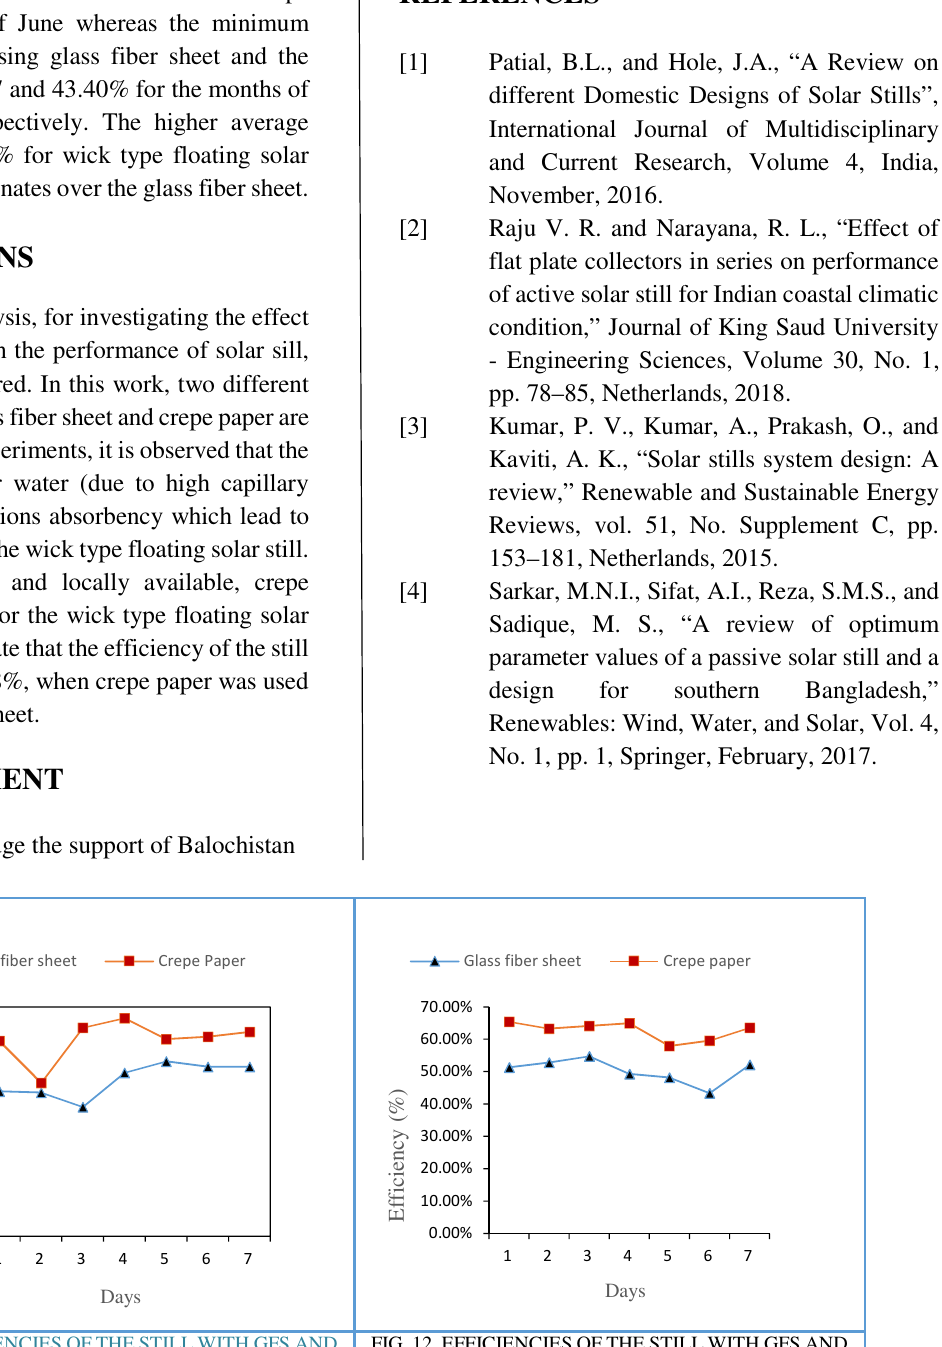
FIG. 12. EFFICIENCIES OF THE STILL WITH GFS AND CREPE PAPER FOR